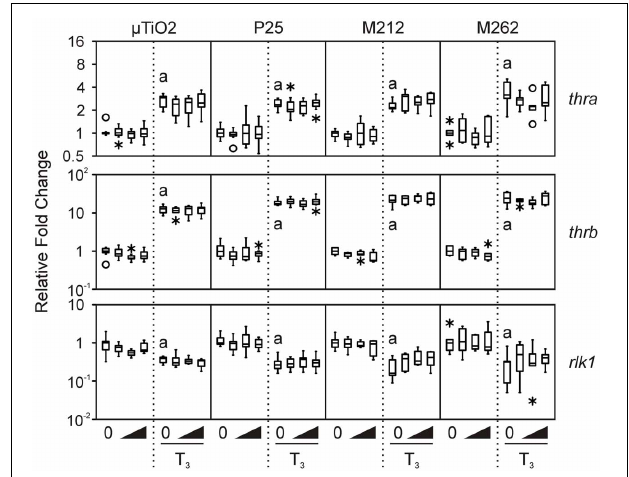
FIGURE 2 | Assessment of the effects of exposure to 0.1, 1.0, and 10nM µ TiO 2 , P25, M212, or M262 on thra, thrb , and rlk1 relative transcript levels in R. catesbeiana tailfin biopsies following 48h exposure to NaOH vehicle or 10nM T 3 . Values represent fold-change of steady-state transcript levels relative to each individual’s vehicle control baseline as measured by QPCR. Bevels indicate increasing concentrations of the indicated compoundin the absence or presence of T 3 . Significant response to T 3 relative to the vehicle control is indicated by “a” when p ≤ 0 . 05. thra , thyroid hormone receptor α ; thrb , thyroid hormone receptor β ; rlk1 , Rana larval keratin type I. See Figure 1 legend for more graph details.